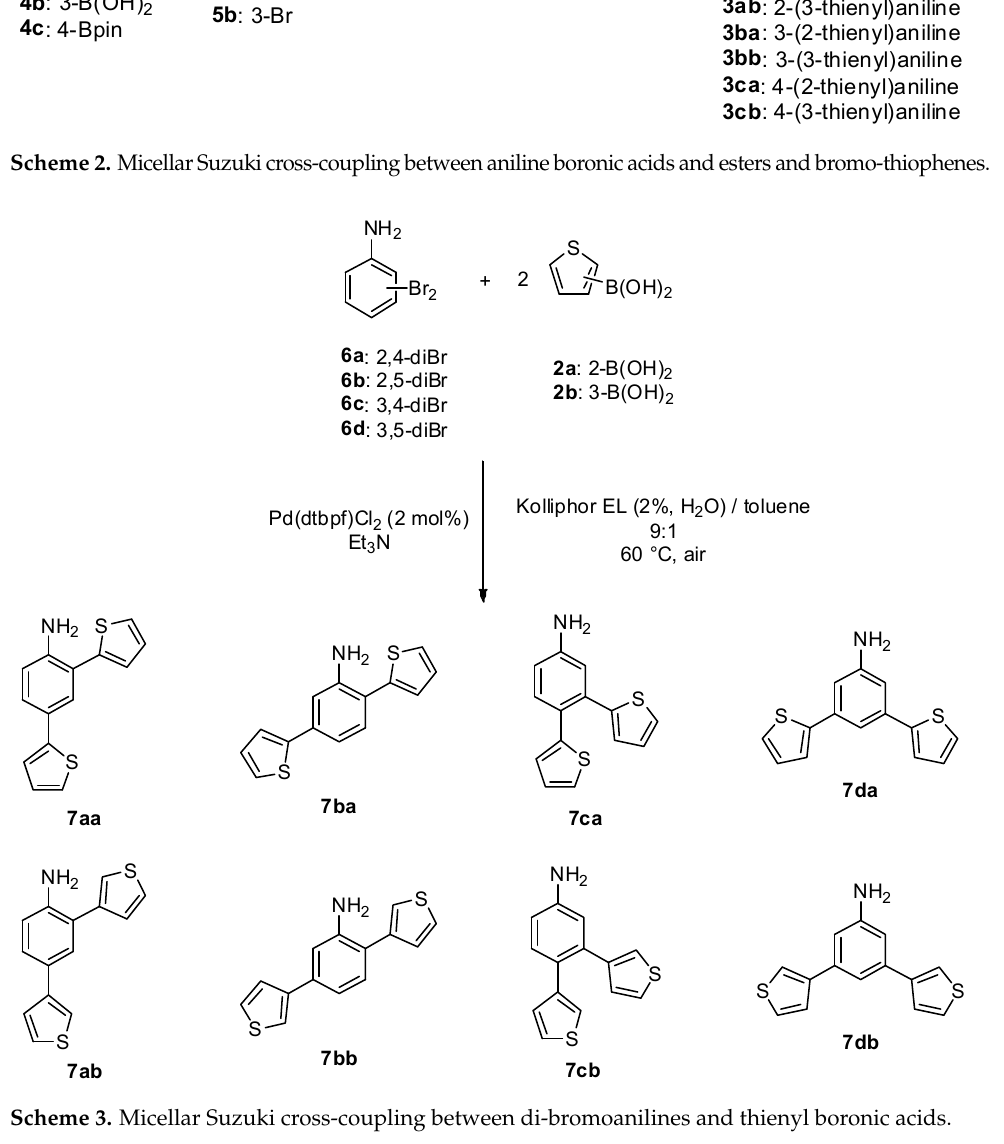
Table 3. Output of micellar Suzuki cross-coupling between di-bromoanilines and thienyl boronic